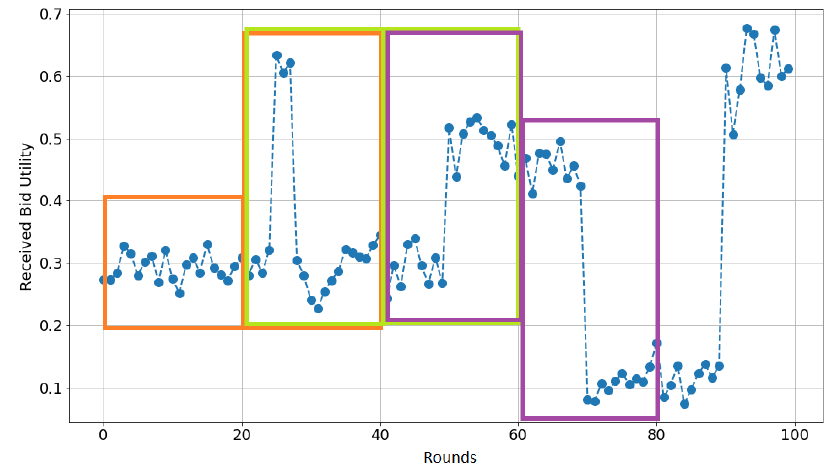
Figure 2. The concept of bid window. In the figure, the reader can observe four consecutive windows of k